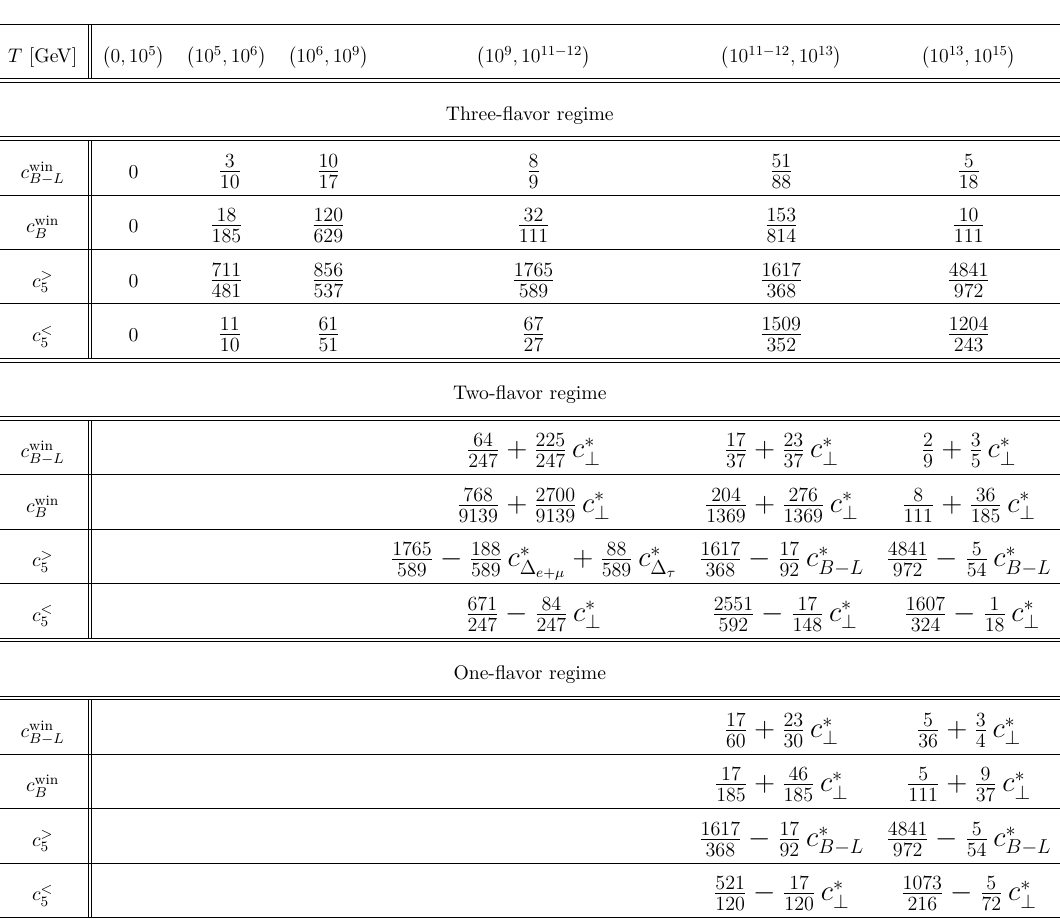
and c win B − L B